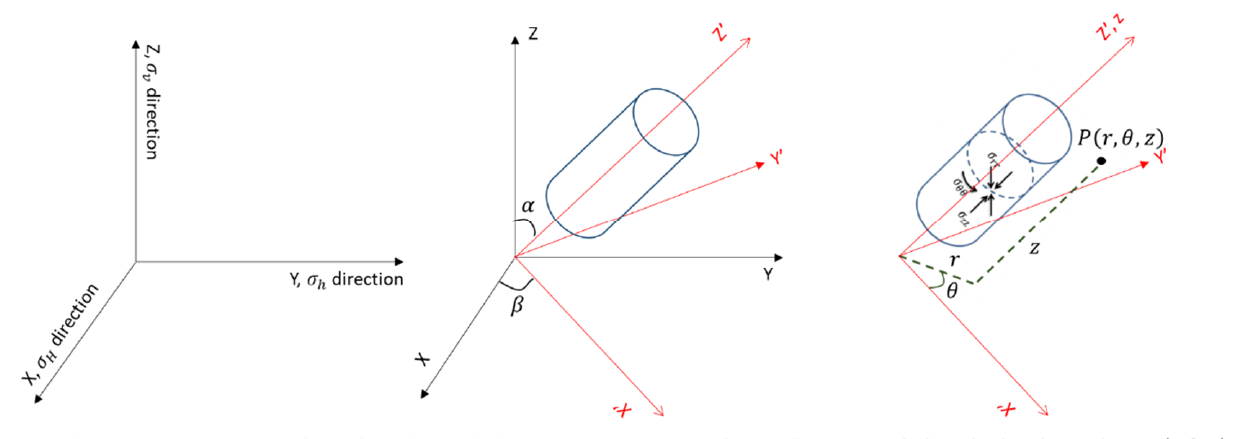
Figure 7. Coordinate systems for stress transformation.